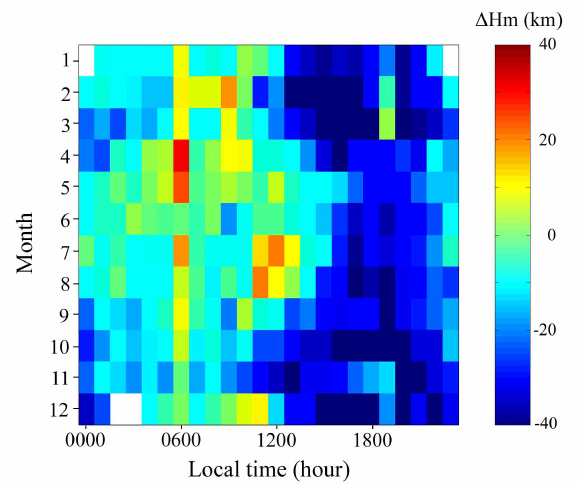
Fig. 3. The difference ( 1 Hm) of monthly median Hm between so- lar minimum and maximum. Notice that the 1 Hm is obtained by subtracting the monthly median Hm for solar maximum from that for solar